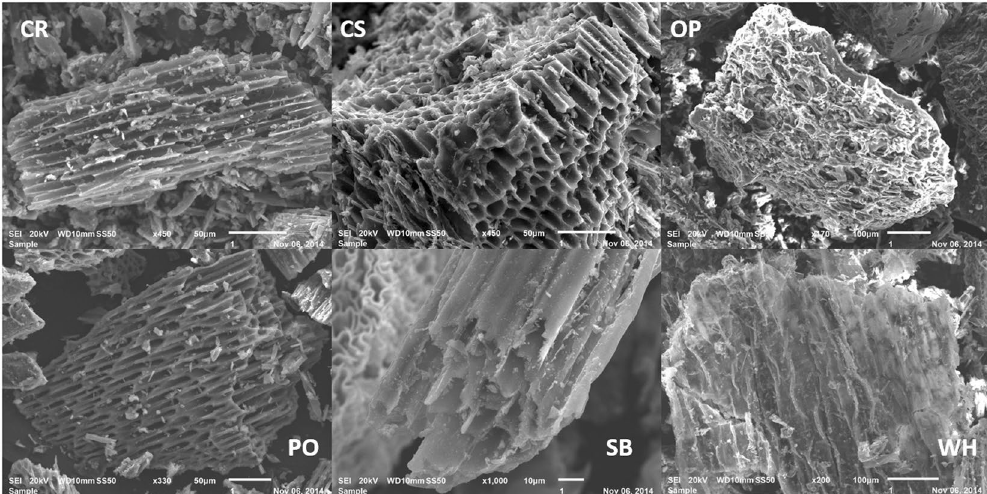
Figure 1. Scanning electron micrographs of biochar samples at magnifications of 450 × (CR, CS), 170 × (OP), 330 × (PO), 1000 × (SB), and 200 × (WH). (CR = charcoal fines; CS = coconut shell; OP = orange peel; PO = palm oil bunch; SB = sugarcane bagasse; WH = water